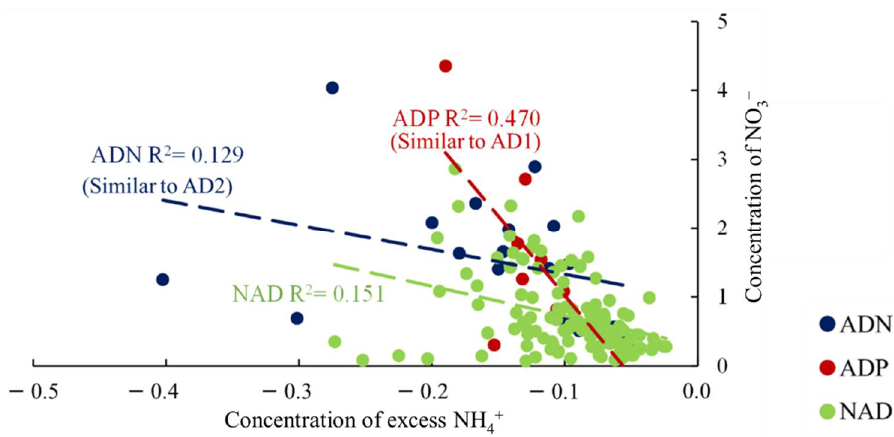
Figure 8. Linear regression of concentration of excess NH 4+ and with concentration of NO 3 − during the long-term observation from 2010 to 2015. ADN can be regarded as similar to the situation of AD2; ADP can be regarded as similar to the situation of AD1.